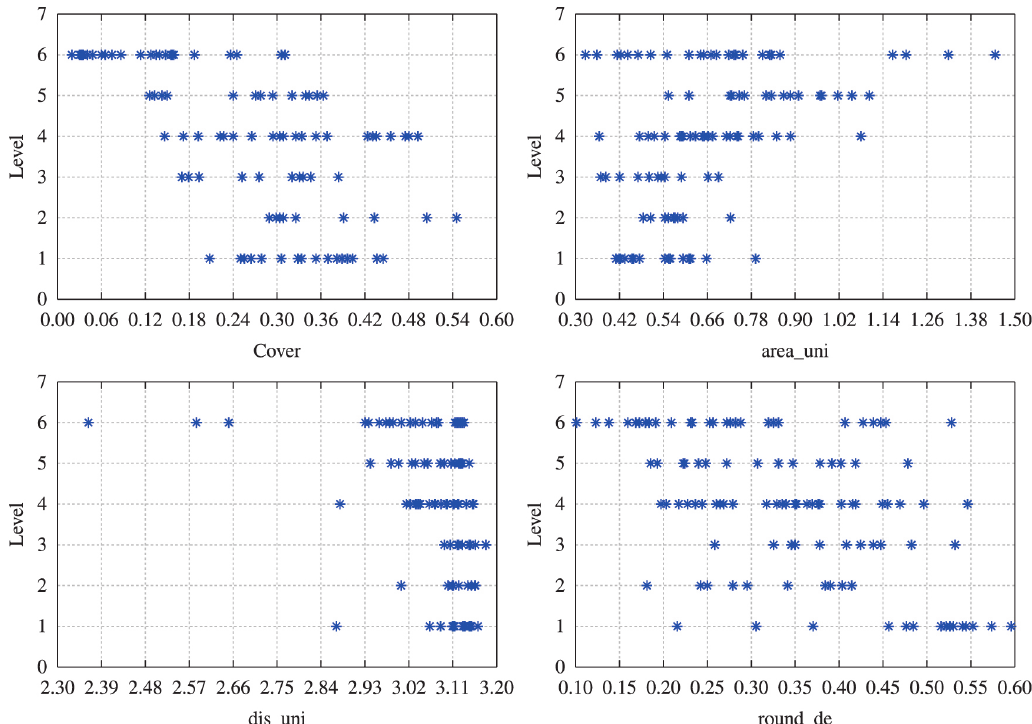
Figure 8. The characteristic parameters of samples with various hydrophobic